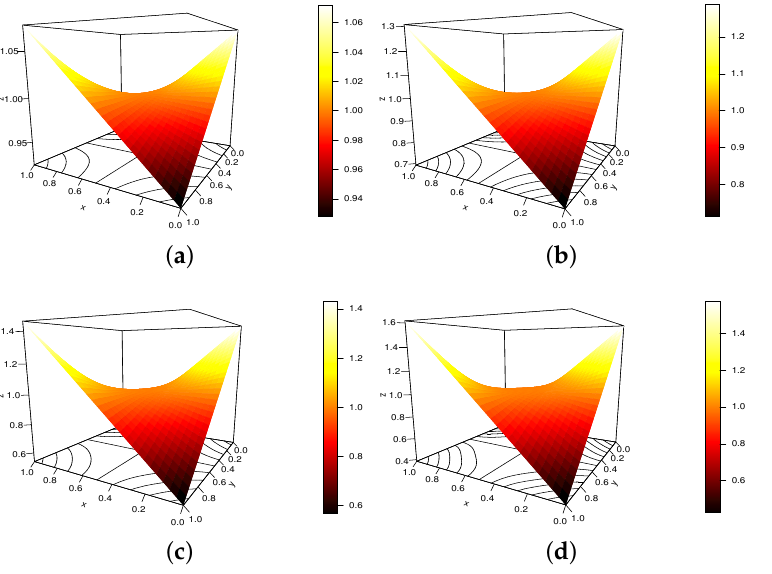
Figure 4. Display of the S copula density for α = 0.049, γ = 1, and ( a ) β = π /2, ( b ) β = 2 π , ( c ) β = 3 π and ( d ) β = 4 π